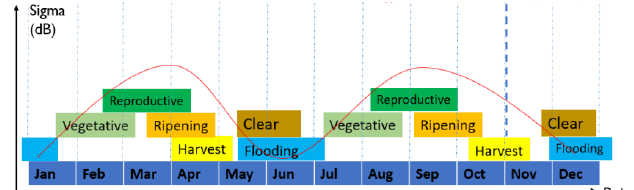
Fig.4: Variation of backscattering coefficients with rice growth